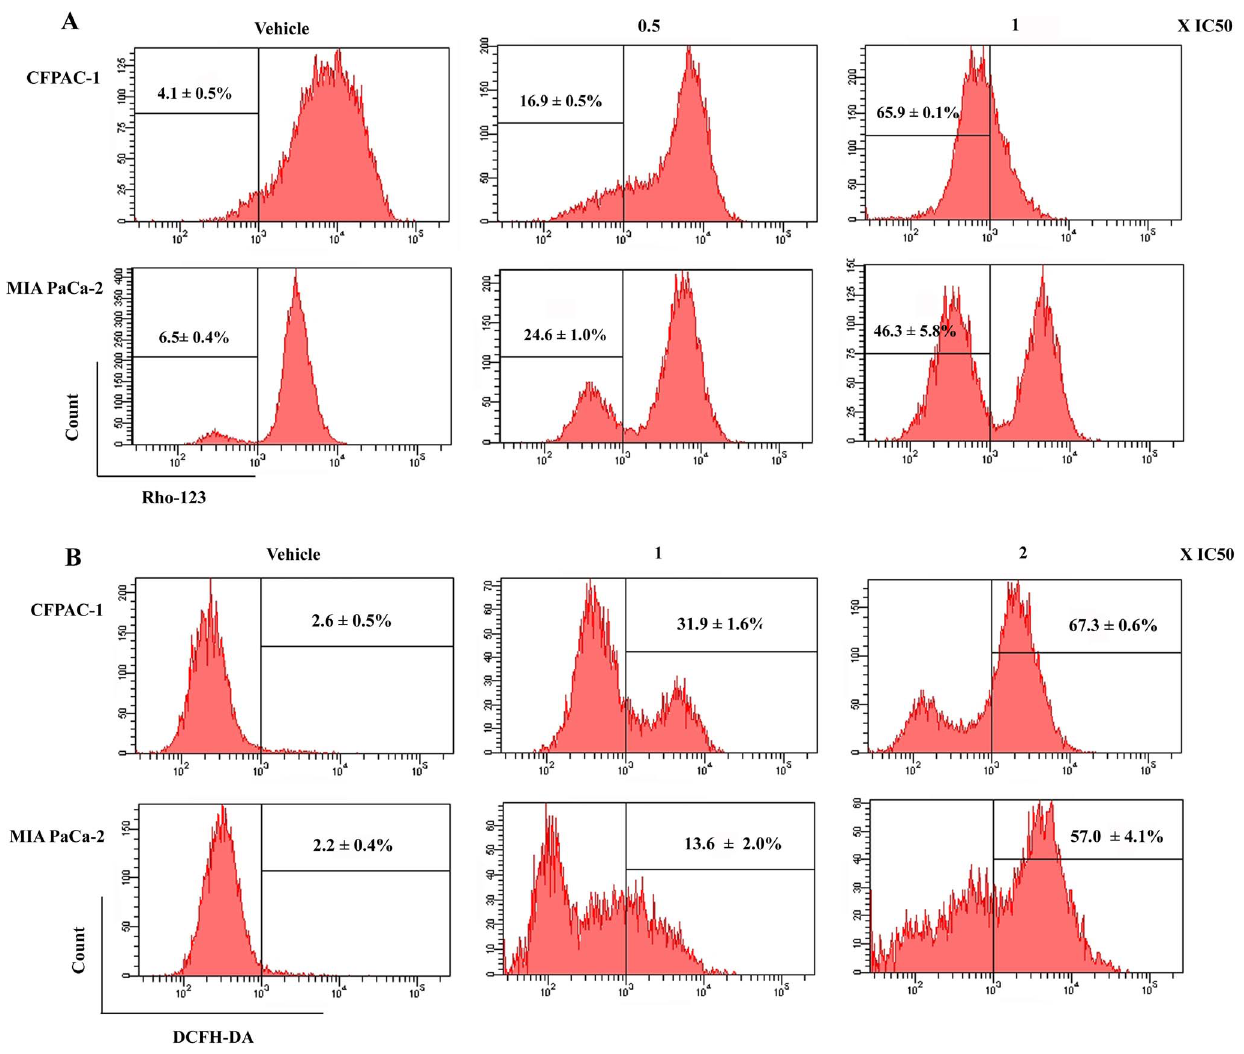
Figure 5. Analysis of the loss of DY m (A) and the generation of ROS (B). The cells were treated at the indicated dose for 48 and 2 h and thereafter subject to FCM for the detection of DY m and ROS, respectively. Representative results from three independent experiments are shown; and each value represents mean 6 SD in three independent experiments.